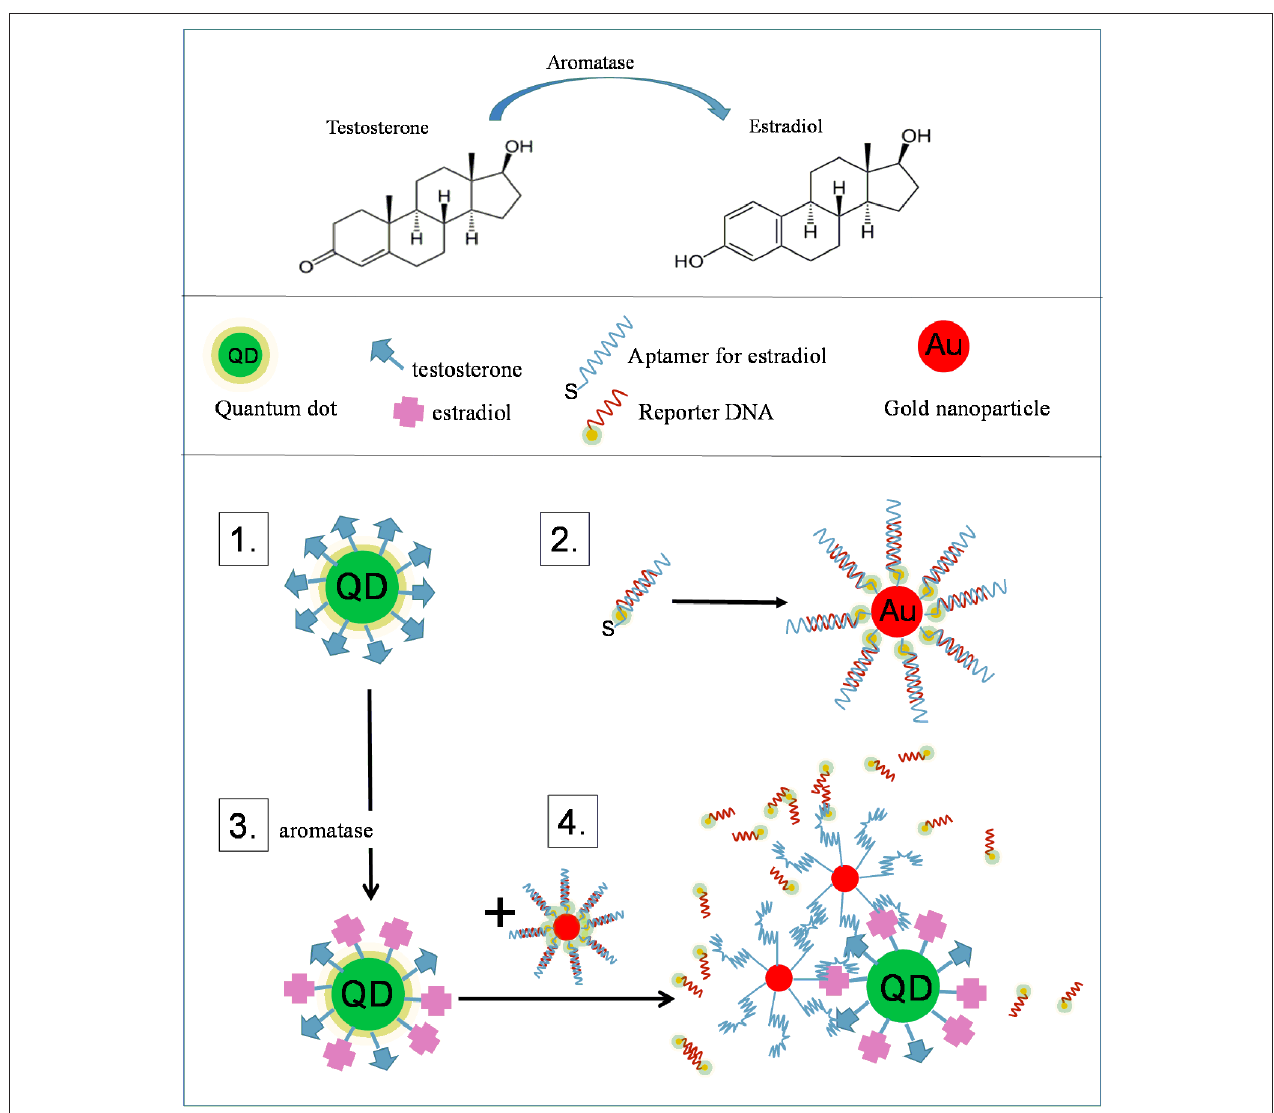
FIGURE 6 | A schematic of the aromatase AuNP-based sensor. Aromatase converts testosterone to estradiol. (1) The substrate of aromatase, testosterone is covalently conjugated to the surface of quantum dots, QDs (“QD-testosterone”). (2) Thiol-terminated estradiol-binding aptamers are allowed to form a complex with their fluorophore-labeled complementary DNA strand (reporter DNA). This complex is attached to the surface of AuNPs through the thiol groups of the aptamer (“AuNP-aptamer”). The fluorophore is quenched by the AuNP. (3) In the presence of aromatase some of the QD conjugated testosterone is converted to estradiol. (4) Upon addition of AuNP-aptamers, the fluorescently labeled reporter DNA is released and the aptamer binds to the estradiol. The fluorescence of QDs is quenched by the close proximity of AuNP, while the fluorescence of the released reporter DNA is restored. In addition, the aggregation of AuNPs and QDs results in a very distinct change in the surface plasmon absorption spectrum of AuNPs. The triple detection system (QDs, fluorophore and AuNP) allows for monitoring conversion of testosterone to estradiol separately (by QD quenching, fluorophore turn-on, NP aggregation).